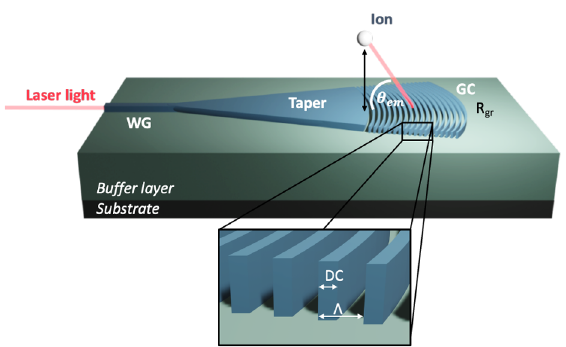
Figure 2. Sketch of a backward grating coupler. Laser light (red) is guided to the grating coupler (GC) via a waveguide (WG). A GC usually consists of a taper and a grating structure. The laser beam leaves the chip with the emission angle ( θ em ) via the grating to interact with the ions. The properties of the emitted laser beam are defined by the period ( Λ ), the duty cycle (DC) and the radius of curvature R g r of the grating.